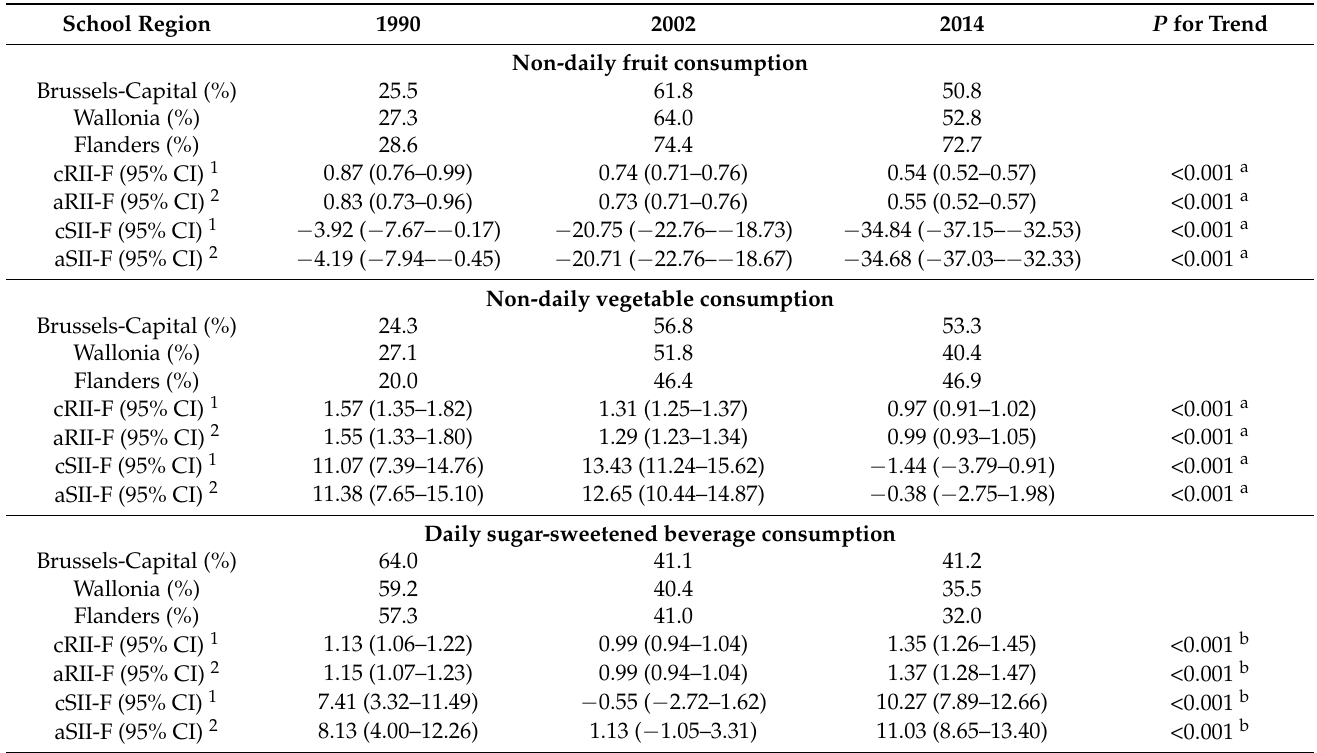
Table 2. Prevalence and Relative Index and Slope Index of regional Inequalities (RII-R and SII-R) of fruit, vegetable and sugar-sweetened beverage consumption among adolescents between 1990 and 2014 (HBSC, Belgium, 1990–2002–2014). School Region 1990 2002 2014 P for Trend Non-daily fruit consumption 25.5